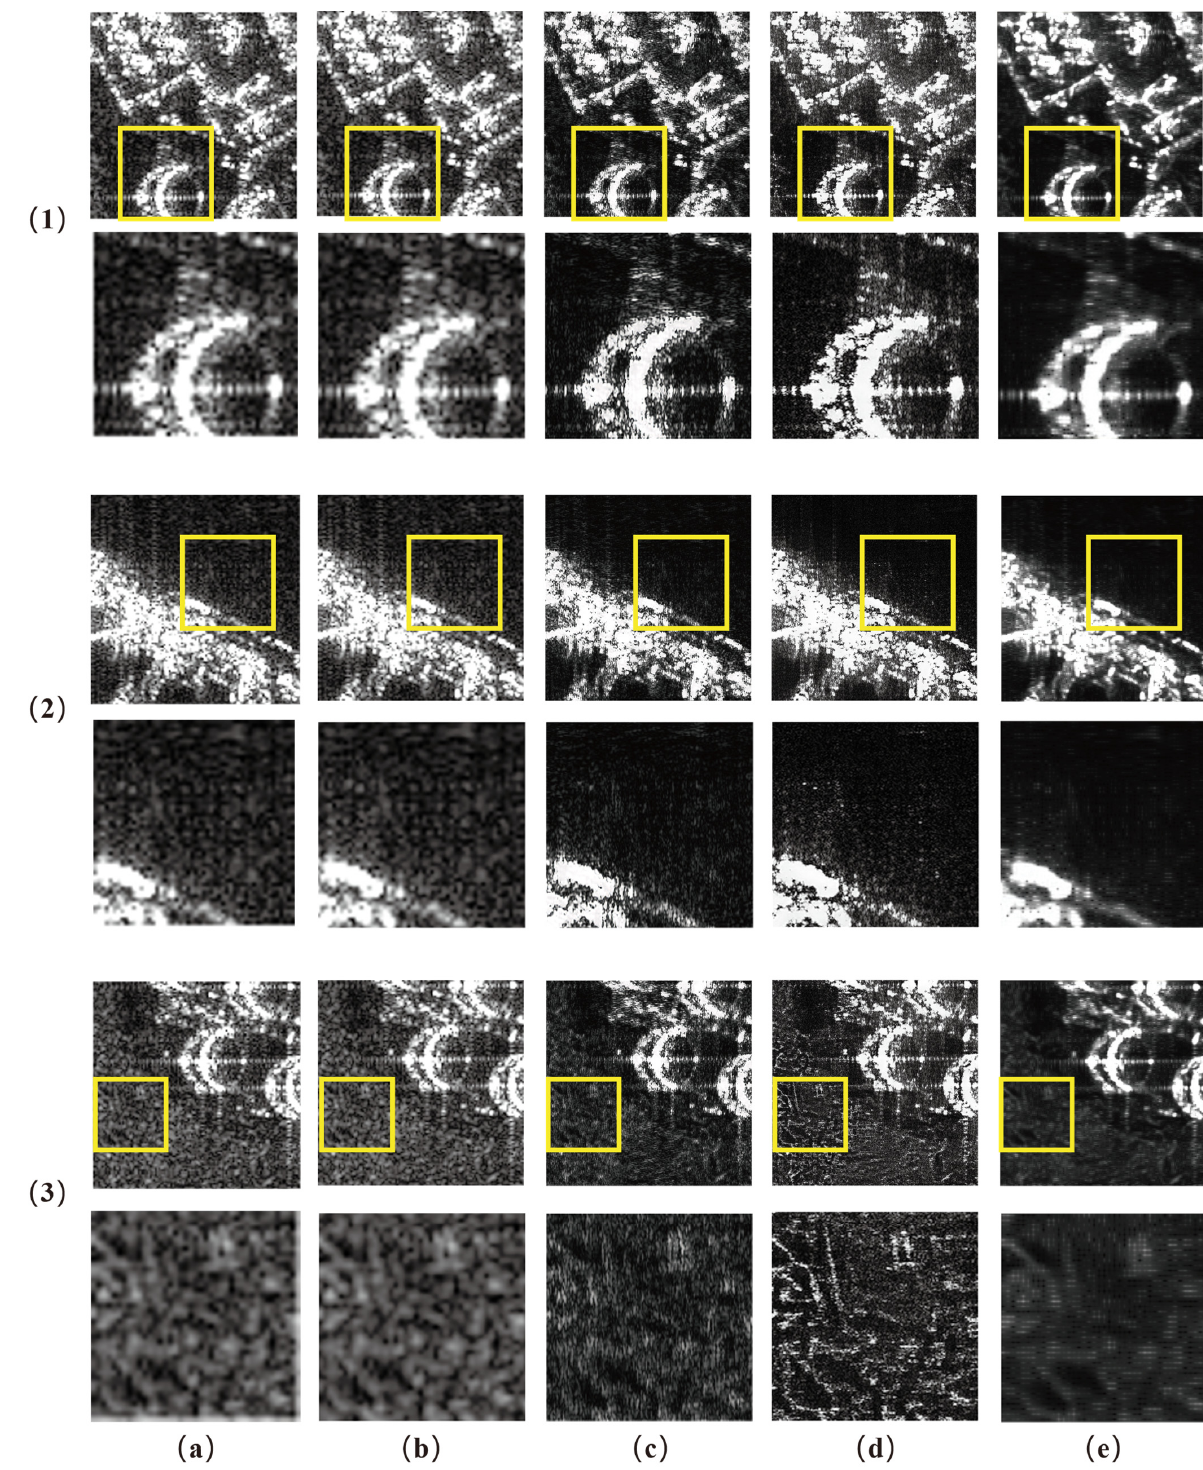
Figure 7. Visual results of real SAR image dataset. The second row is the enlarged view of the first row in each of three paired pictures. ( a ) Input image (real LR image). ( b ) Bicubic interpolation. ( c ) SNGAN. ( d ) Real ESRGAN. ( e ) The proposed method. (1)–(3) represent three pairs of examples to illustrate the performance. The second row of each pair of examples is the enlarged view of the corresponding yellow box in the first row.